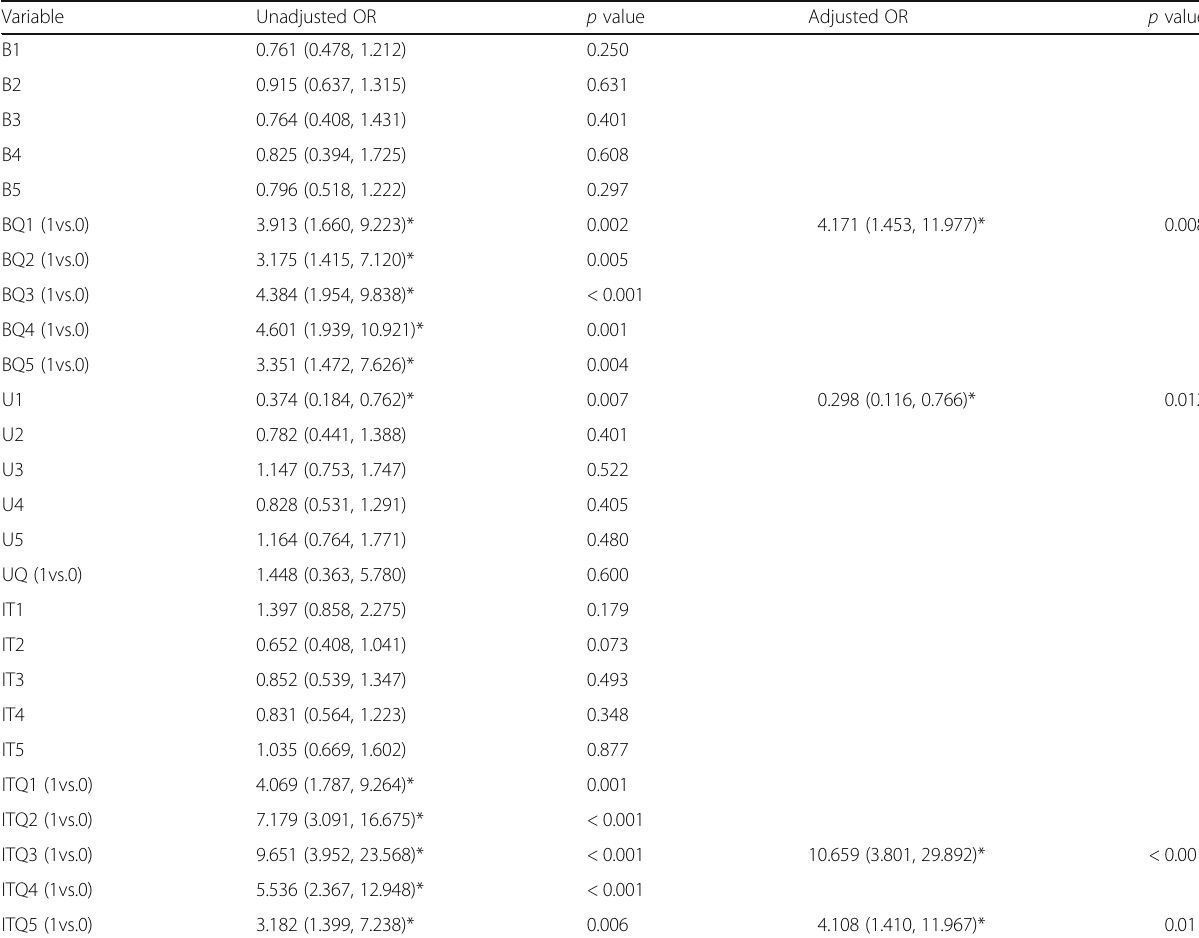
Table 5 Platform logistic regression results